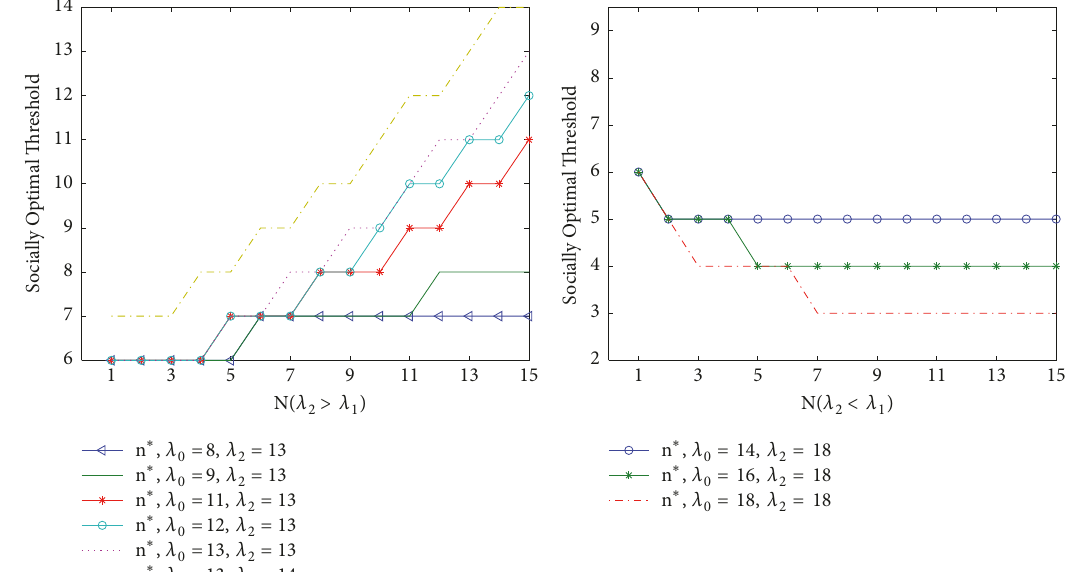
Figure 7: Left: socially optimal threshold in the observable case vs. 𝑁 ( 𝜆 2 > 𝜆 1 ) for 𝑅 = 30, 𝐶 1 = 20, 𝐶 2 = 15, 𝜆 1 = 10. Right: socially optimal threshold in the observable case vs. 𝑁 ( 𝜆 2 < 𝜆 1 ) for 𝑅 = 30; 𝐶 1 = 15; 𝐶 2 = 10; 𝜆 1 = 20.